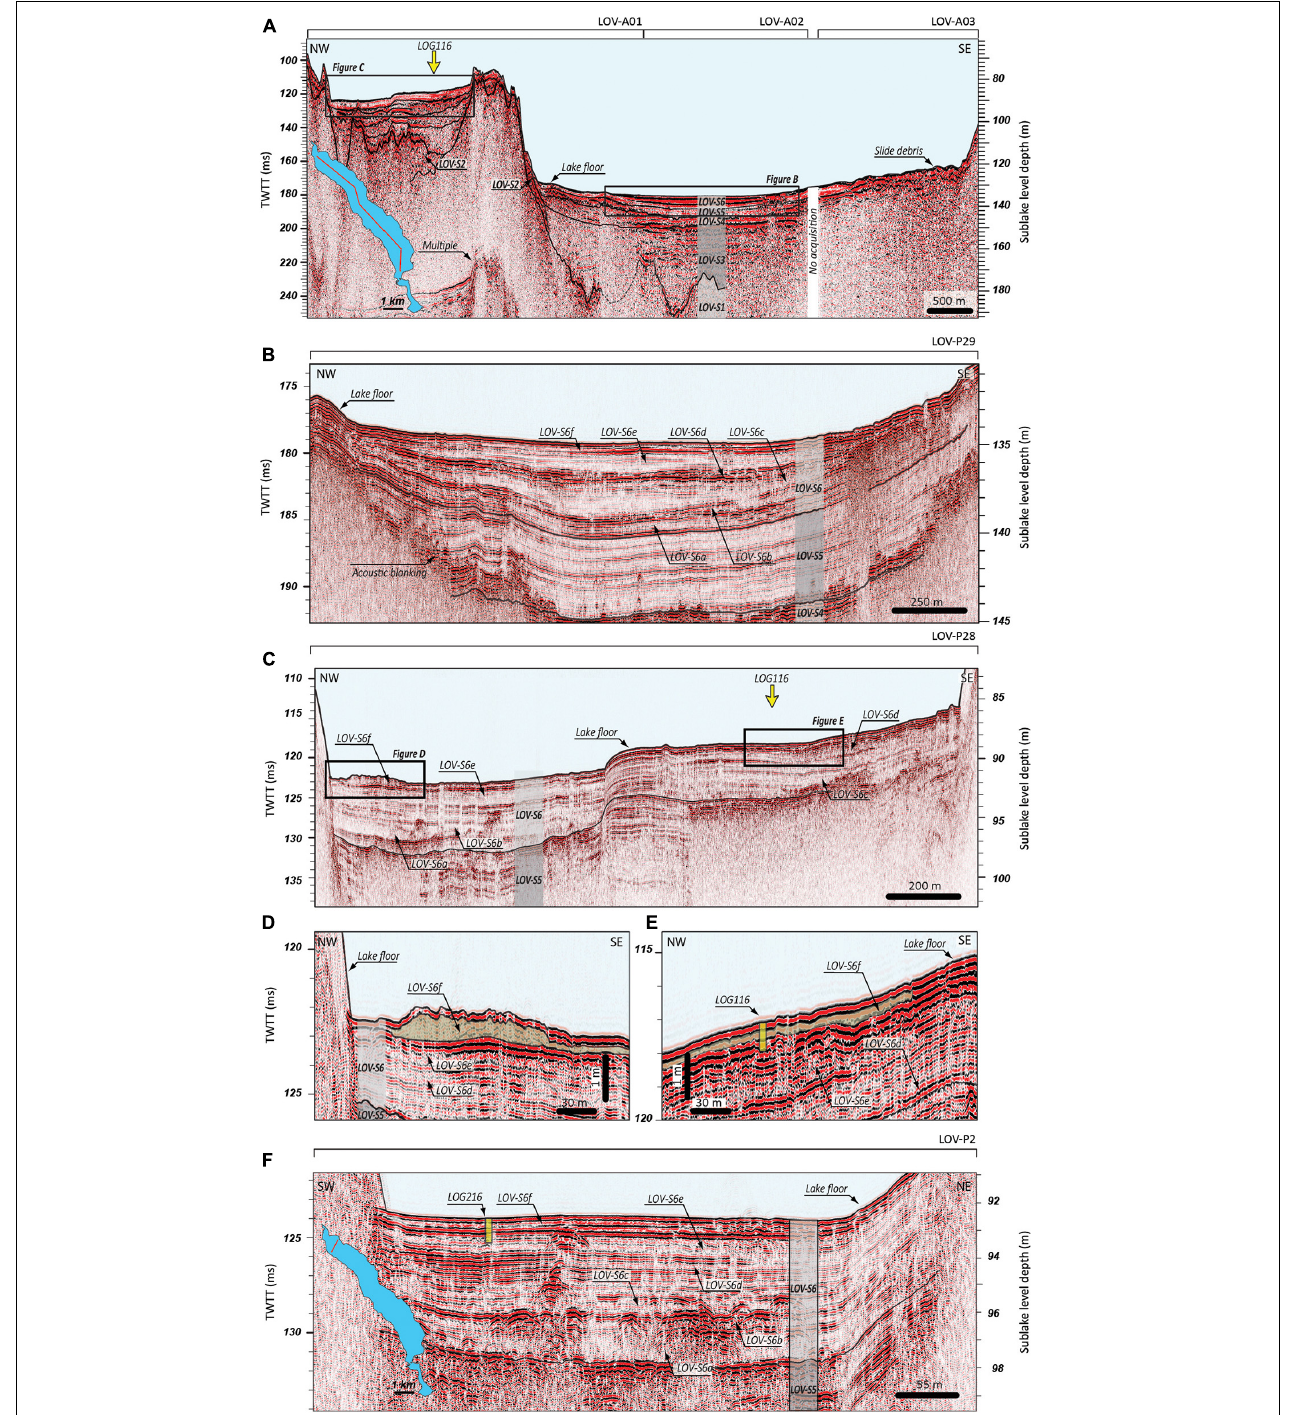
FIGURE 6 | (A) Longitudinal airgun seismic profile across the lake axis (NW-SE). Location of the airgun line is marked in the map. (B) Pinger profile P29 across the SE sub-basin, with location marked in (A) by a black square. Internal stacked sub-units are marked (LOV-S6a to LOV-S6f) and stands for a series of rock falls and debris flows (see discussion for more detail). (C) Pinger profile in the shallow sub-basin (location in A ). (D) Zoomed area in (C) near the lake’s outlet highlighting the local increase in thickness of LOV-S6f, probably as a result of the seiche effect and local contribution to the debris. (E) Zoomed area in the location of the cores retrieved in the lake, with highlight of LOV-S6f. (F) Pinger profile P2 across the NW sub-basin, location marked in the inlet figure. Location of core LOG216 is marked, as well as the stacked subunits of LOV-S6 (LOV-S6a to LOV-S6f).